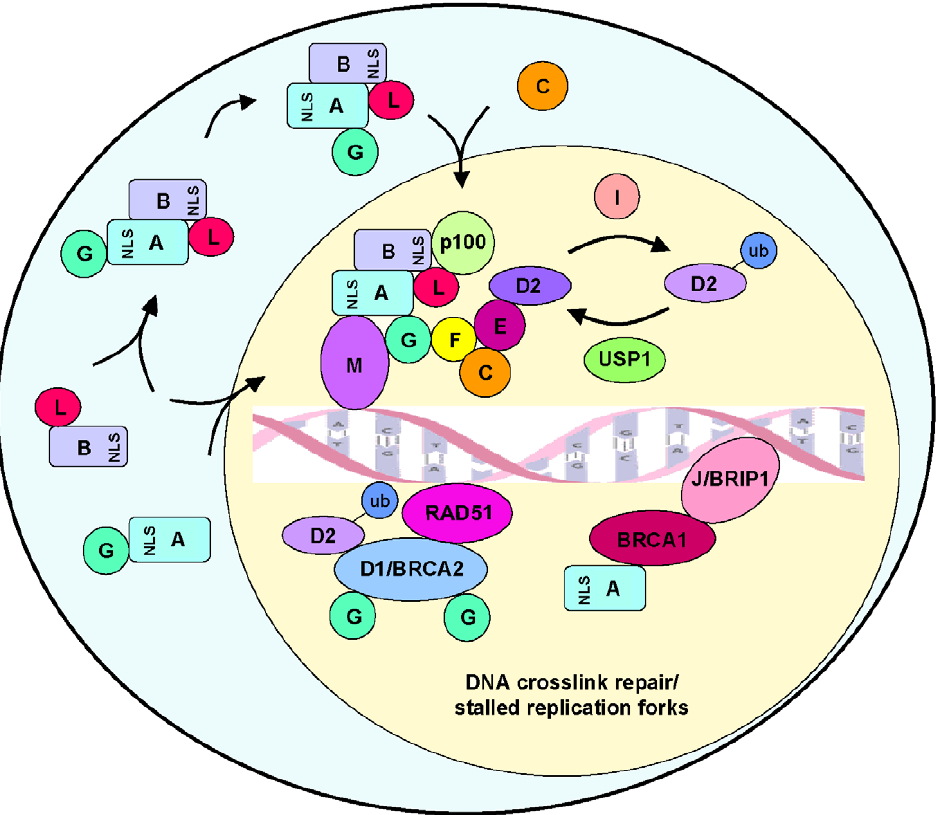
Fig. 6. Current view of the FA pathway showing how the FA proteins interconnect. FANCA and FANCG bind in the cytoplasm and presumably interact with FANCB and FANCL in the cytoplasm or in the nucleus. In the nucleus it combines with FANCM. Binding of FANCF, -E, and -C is essential to stabilize the interaction between FANCM and the FANCA/B/G/L sub-complex and to form the core complex. FANCD2 interacts with this complex through FANCE. The E3-ubiquitin ligase FANCL activates FANCD2 by monoubiquitination at Lys561. FANCI is also required for FANCD2 activation, but its precise role remains to be determined. De-activation is thought to occur through USP1, a de-ubiquitinating enzyme. Activated FANCD2 then co-localizes with BRCA2/FANCD1, RAD51, and BRCA1 in nuclear foci that form at DNA damage sites. FANCD2 is also thought to be involved in uploading of BRCA2 onto the chromatin. FANCJ, a 5 (cid:1) → 3 (cid:1) DNA helicase, directly binds to DNA and may also bind to BRCA1 in a phosphorylation- and cell cycle-dependent manner. Direct interactions of FANCG with BRCA2 and BRCA1 with FANCA have also been reported, although the precise implications of these interactions remain unknown. The intimate connections between FA and HR proteins at the chromatin level may facilitate repair of cross-link damage and/or resolution of stalled replication forks. Figure reproduced, with permission, from the thesis of M.